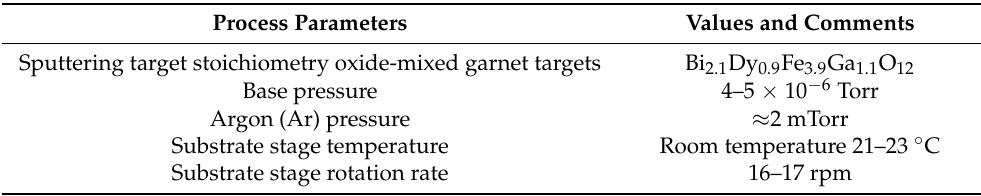
Table 1. Summary of process parameters used to prepare the garnet layers. Process